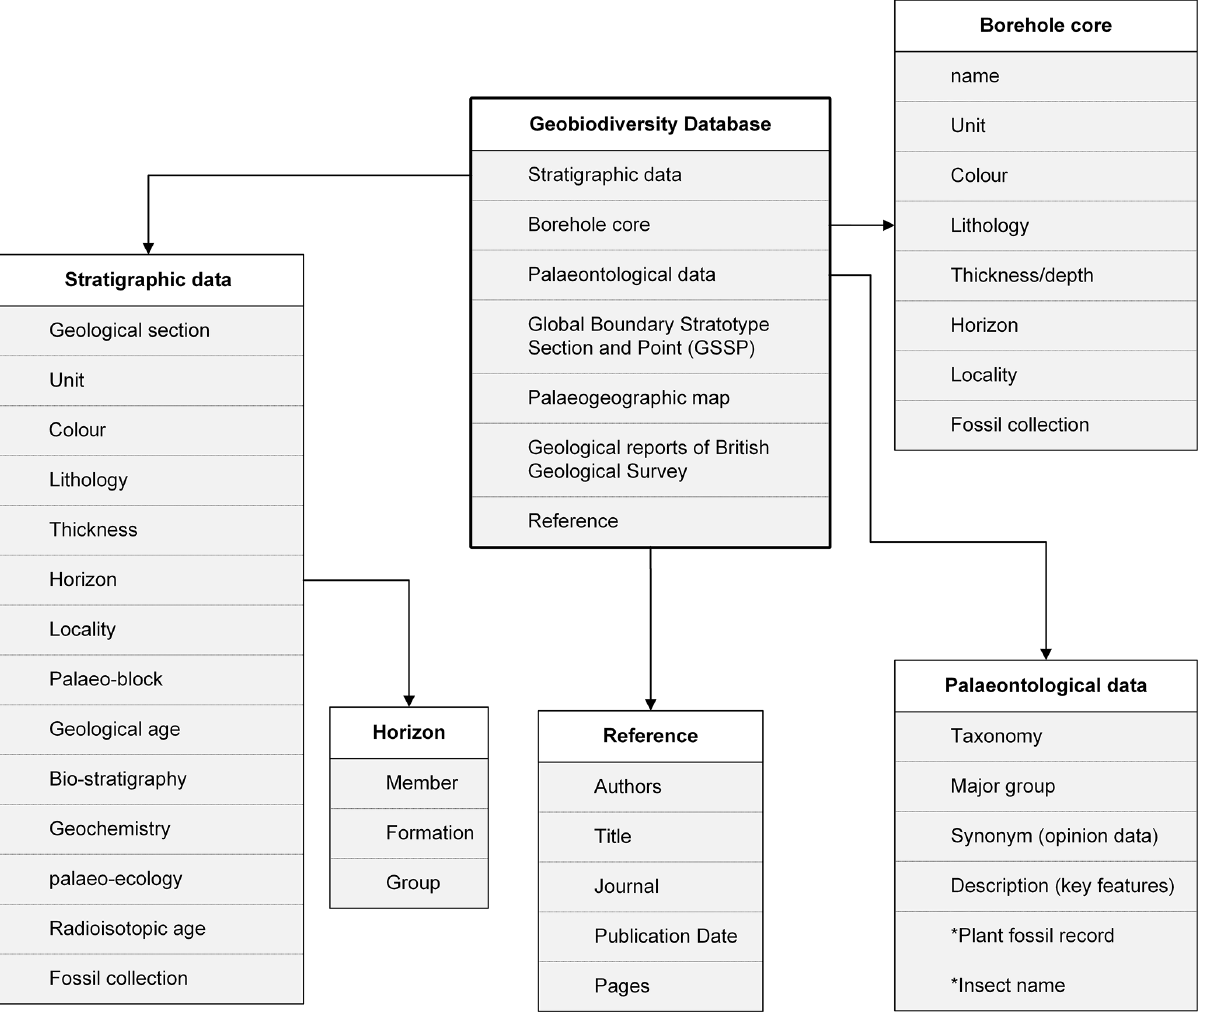
Figure 1. The data structure of the Geobiodiversity Database (GBDB). * The newly added datasets. Table 1. The comparison of the two widely used palaeontological databases. Note that the newly added data of terrestrial organisms, plant and insect fossil records, are not included in the GBDB statistical outcome (in November